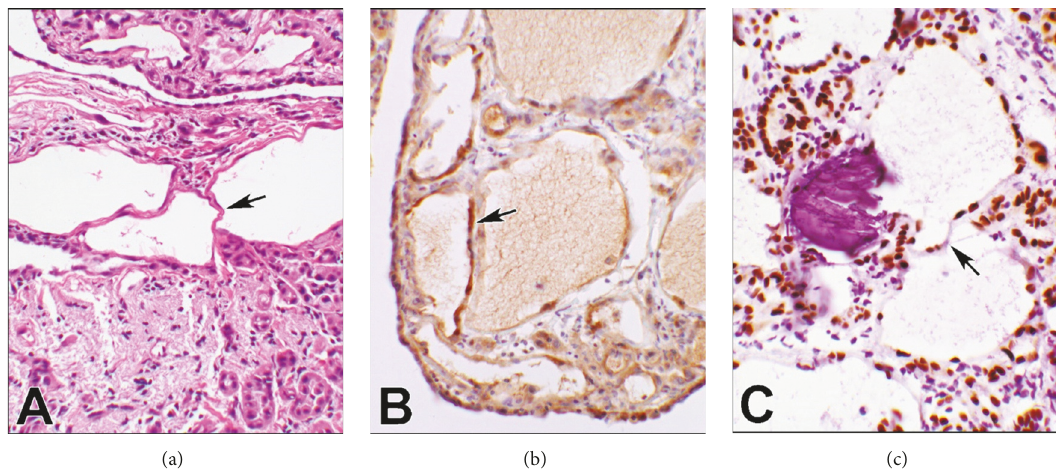
Figure 3: Photomicrographs of thread-like bridging ( 20x objective). The arrows point to the thread-like bridging feature of adenomatoid tumorinallthreepanels.(a)showsthebridgesintheupperpartandthesolidtumormorphologyinthelowersegmentofthephotomicrograph stained with hematoxylin & eosin. (b) is calretinin IHC reaction of the cytoplasm and the nuclei, and (c) is PAX8 IHC reaction of the nuclei. Panel (c) has also captured a psammoma body.